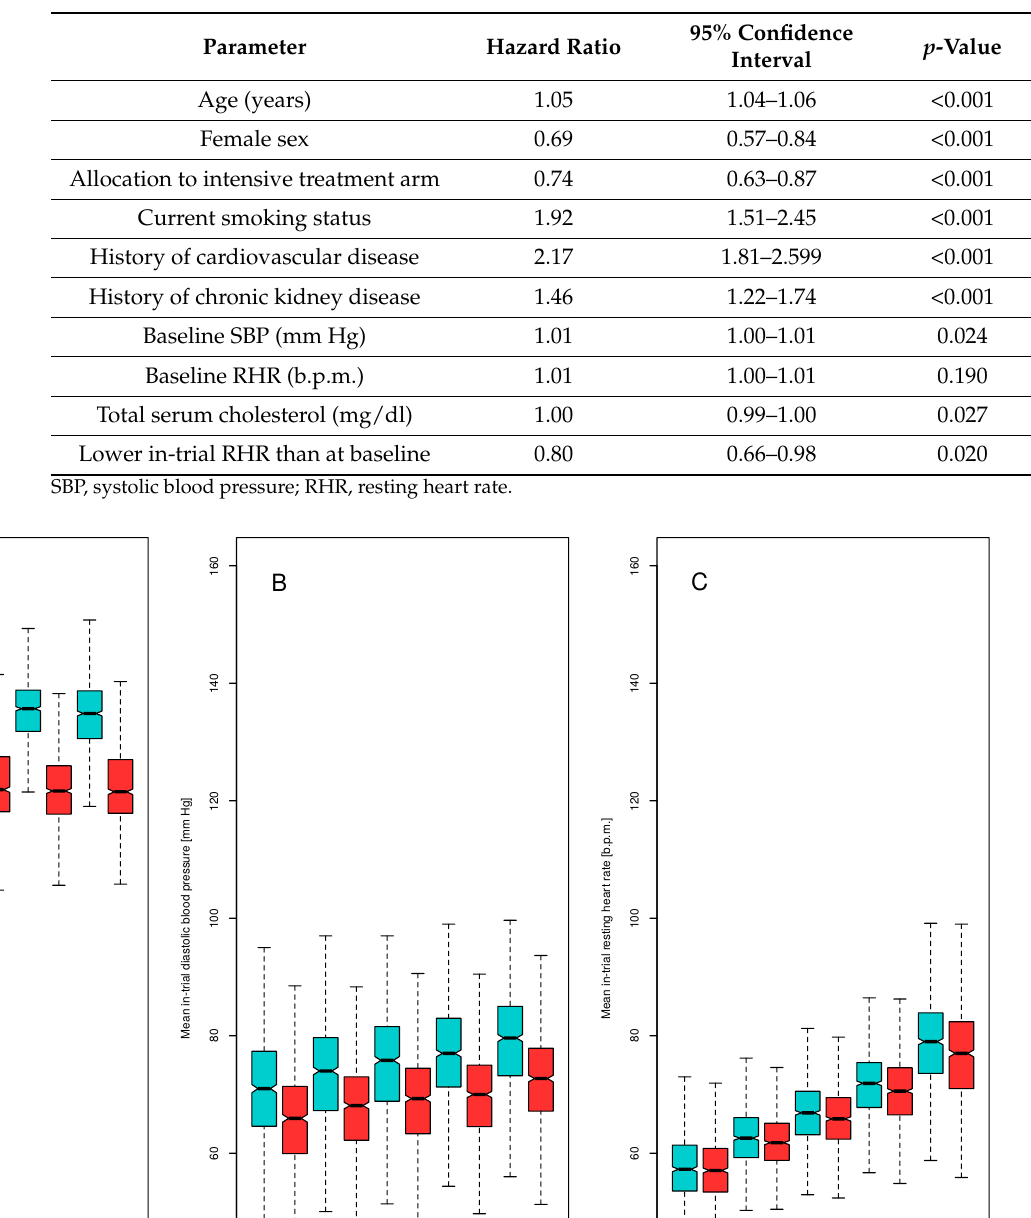
Table 2. Proportional hazard risk model evaluating impact of lower in-trial than baseline RHR.